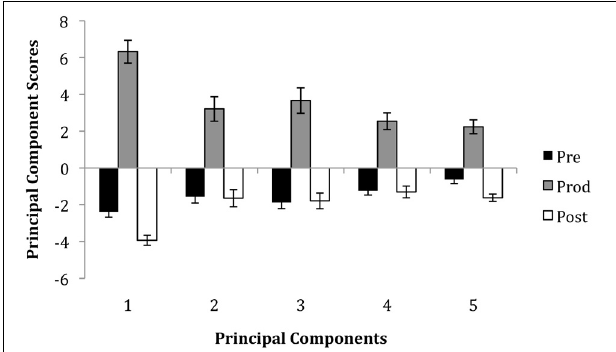
FIGURE 4 | The average principal component scores for each singer. Error bars represent standard